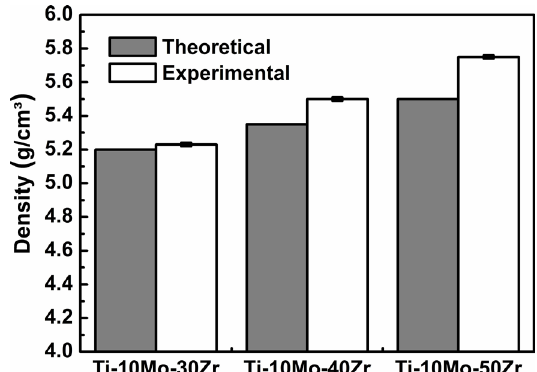
Figure 3. Density of the produced Ti-10Mo-Zr